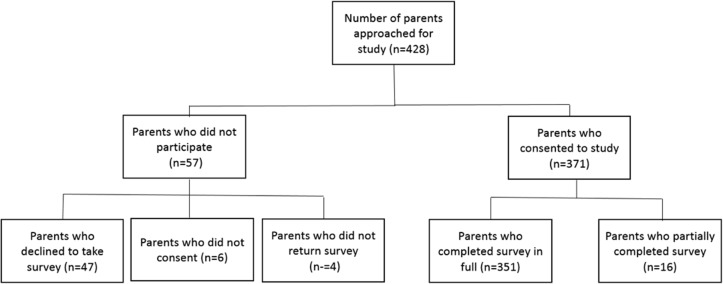
Survey response.